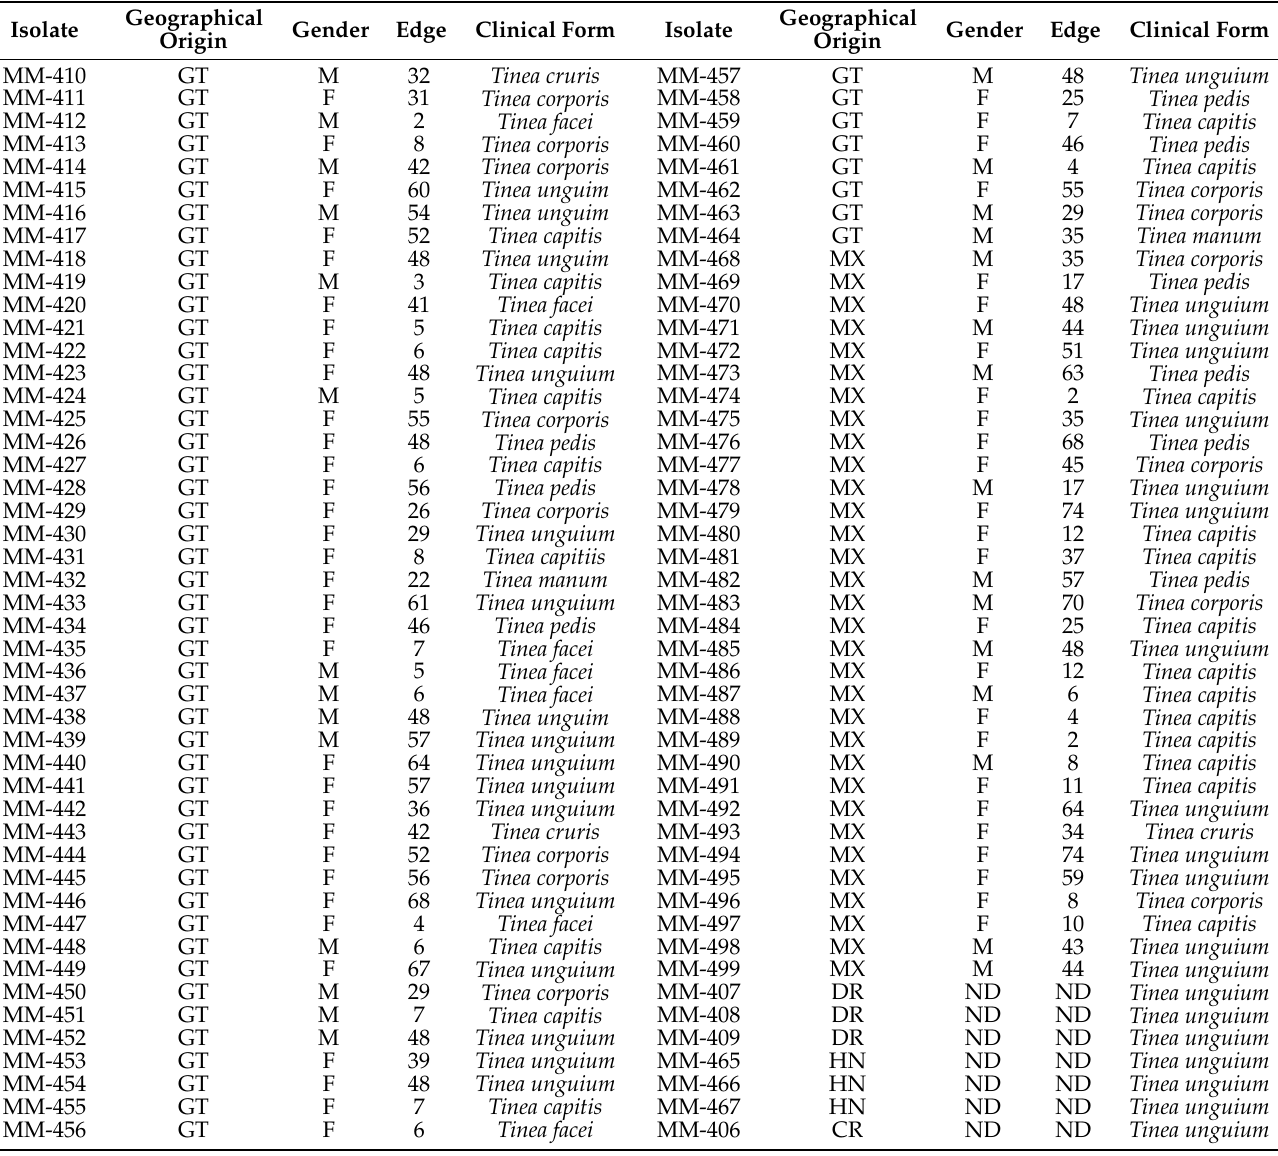
Table 1. Epidemiological data of dermatophyte isolates included in the